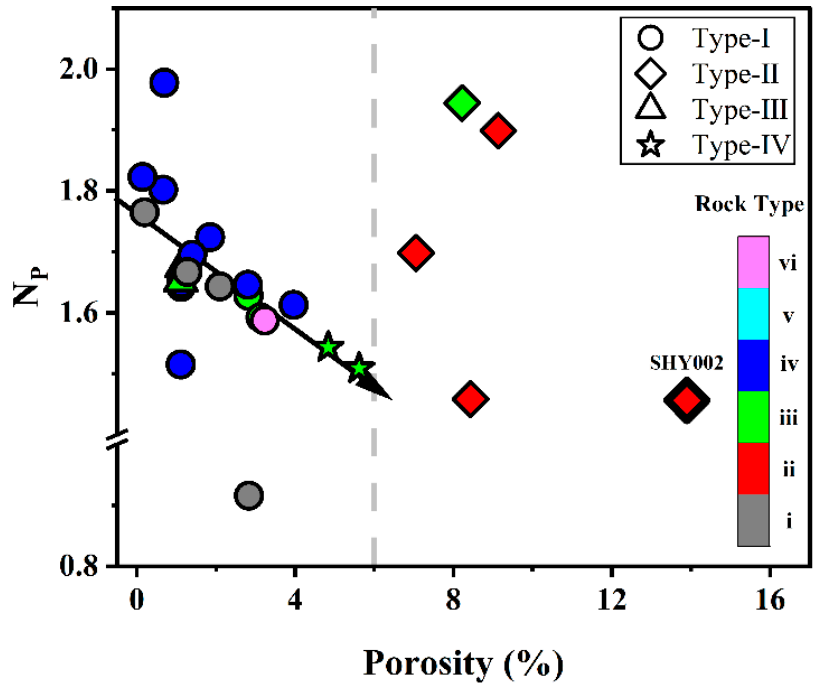
Figure 12. Cross ‐ plot of porosity and porosity cyclicity with rock type superimposed in color. Figure 12. Cross-plot of porosity and porosity cyclicity with rock type superimposed in color. Marker Marker shape represents pore type. shape represents pore